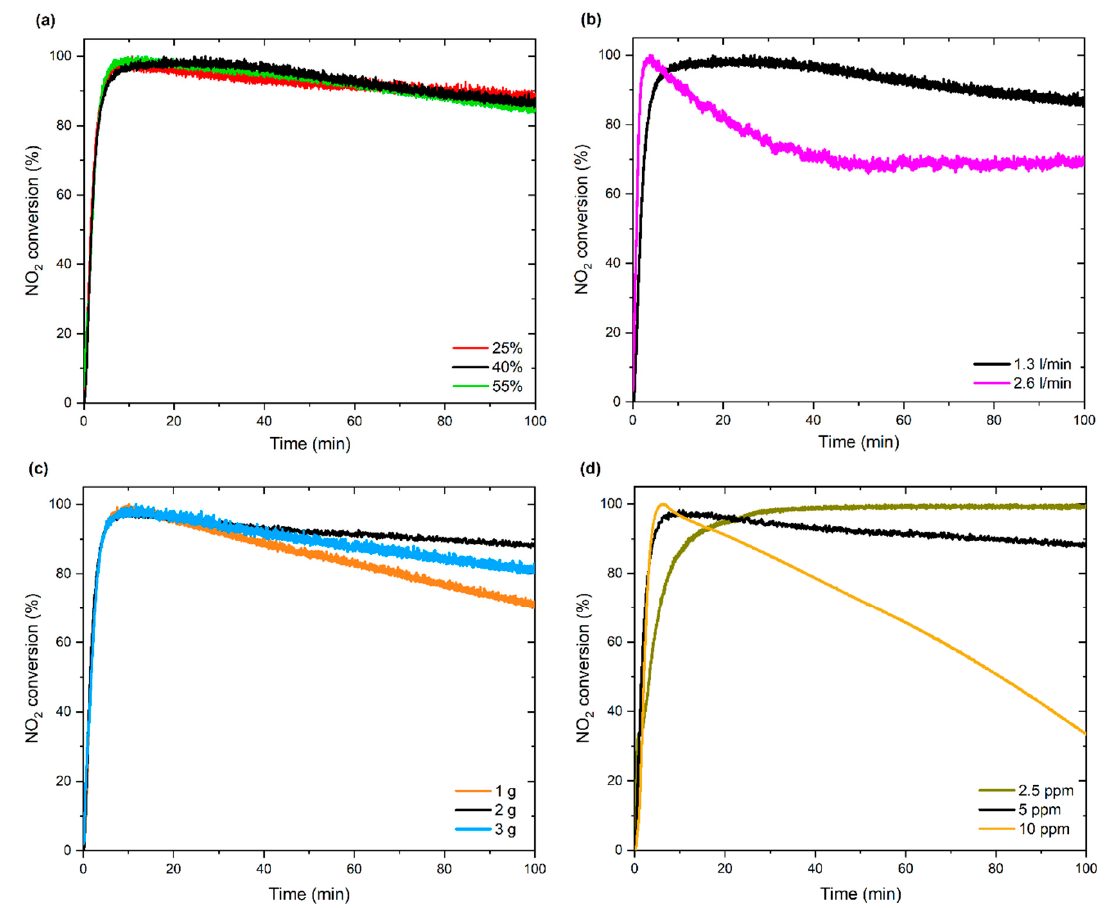
Figure 9. Effect of: ( a ) humidity, ( b ) gas flow, ( c ) photocatalyst amount, and ( d ) NO 2 initial concentration on NO 2 conversion using WO 3 /S-doped g-C 3 N 4 .